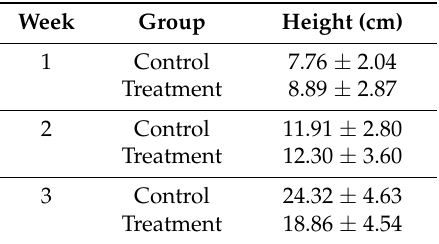
Table A2. Summary statistics for H. annuus height by week and treatment group. Cells contain the mean ± the standard deviation of the mean. For each cell, n = 12.